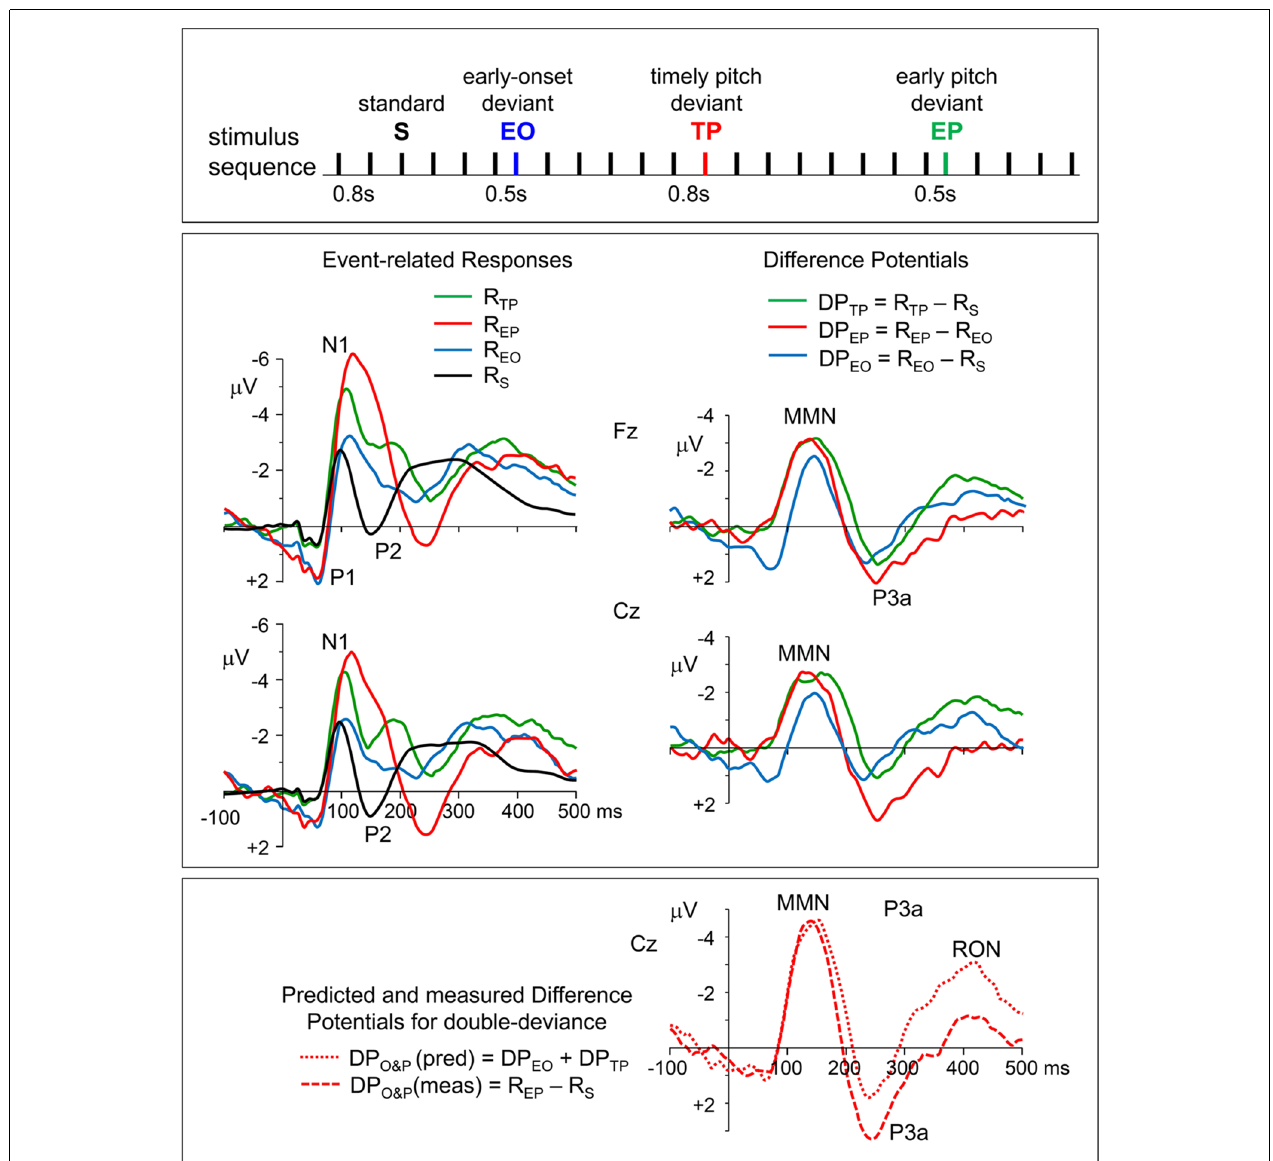
FIGURE 1 | Top panel: stimulation paradigm. Standard inter-onset interval (IOI) between successive tone-pips was 800 ms. Deviant stimuli which differed from standard (S) ones either only in their pitch (TP), or only in their earlier onset time (EO), or in both (EP) were randomly distributed in the sequence in such a way that the number of standards before a deviant changed randomly between 4 and 8, maintaining a probability of around 5% for each of the three deviants. Middle panel, left column: grand average event-related potentials (ERPs) to timely pitch-deviant, early onset timing-deviant, earlier pitch-deviant, and standard stimuli (R TP , R EO , R EP , and R S , respectively). Re-referenced to averaged earlobes. Middle panel, right column: the difference potentials (DPs) obtained for timely (IOI = 800 ms) and earlier (IOI = 500 ms) pitch deviances and for onset deviance due to shortening of the IOI, which were calculated as DP TP = R TP − R S , DP EP = R EP − R EO , and DP EO = R EO − R S , respectively. Bottom panel: the two plots seen on the right of this panel with mismatch negativity (MMN), P3a, and reorienting negativity (RON) waves are the DPs calculated as DP O&P (meas) = R EP − R S and DP O&P (pred) = DP EO + DP TP , to obtain, respectively, the actually measured DP to “IOI&pitch” double-deviant, and its model waveform predicted by assuming additivity of the responses to single deviants (onset or